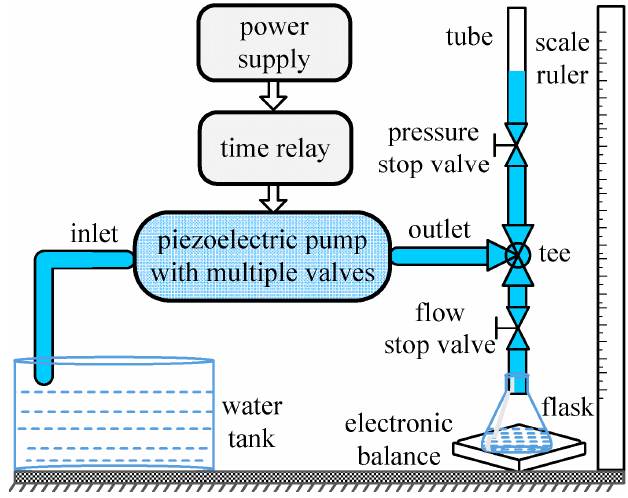
Figure 4. Experimental setup.